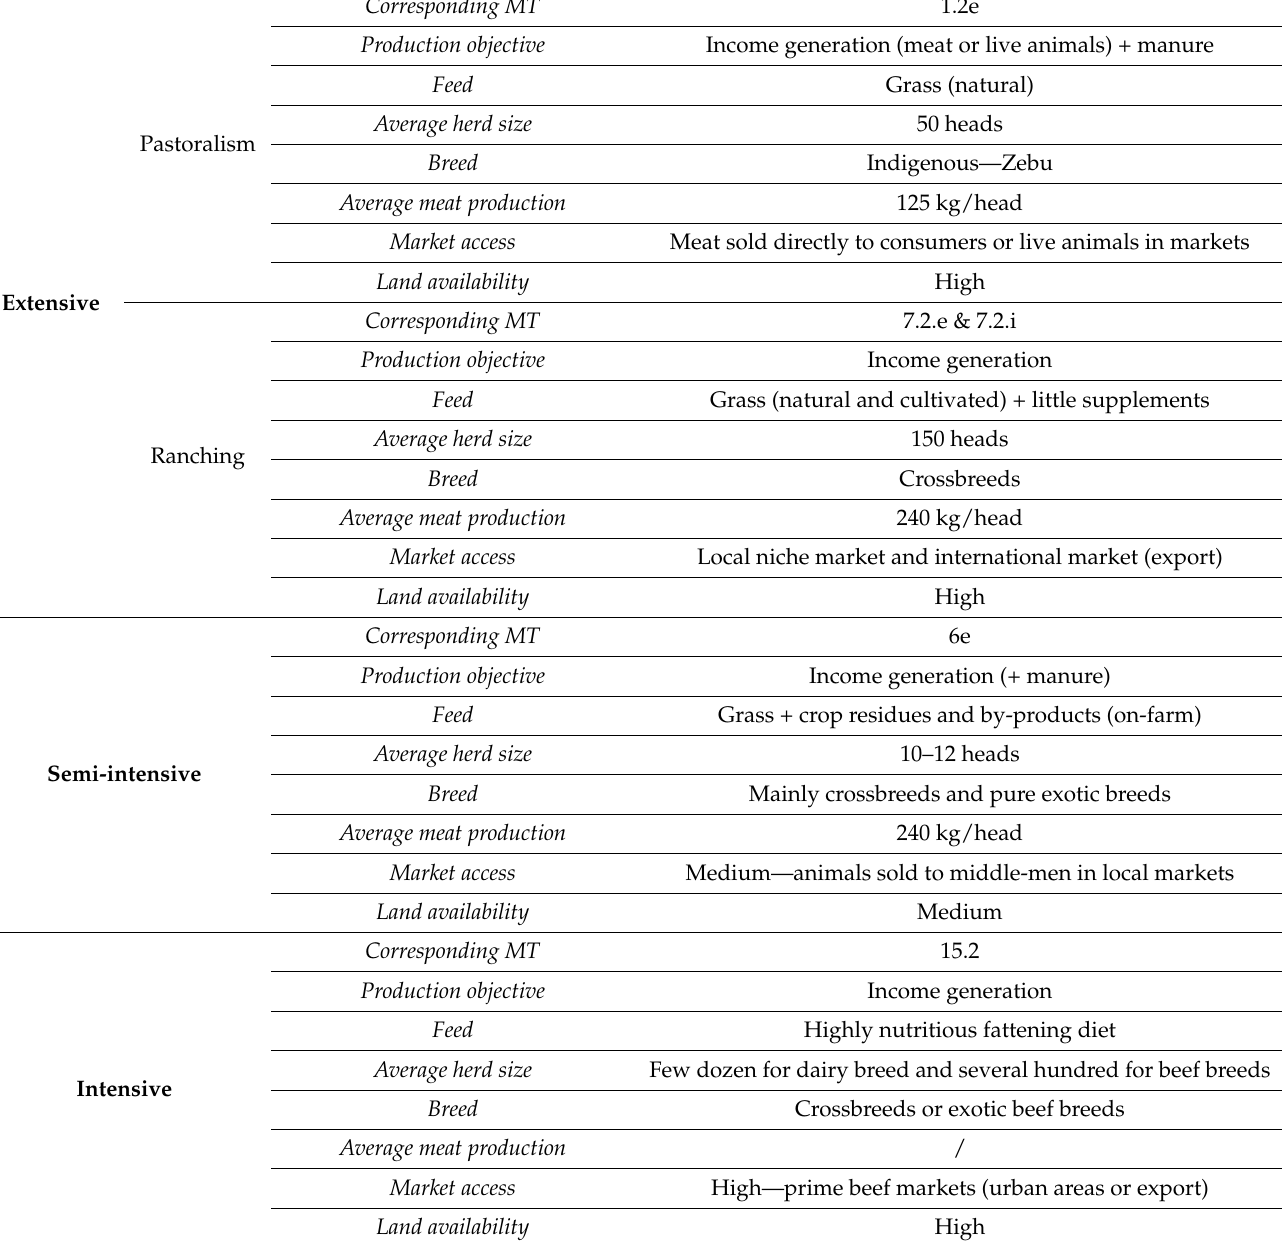
Table 2. Description of beef production systems in Kenya